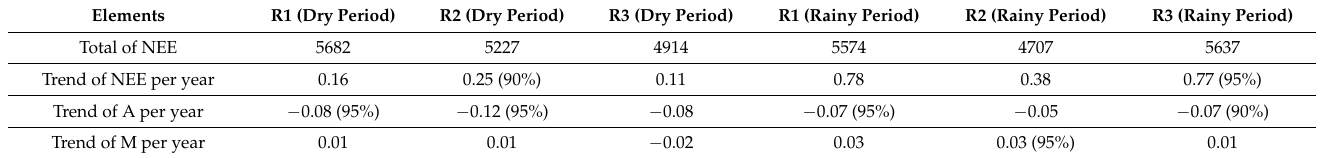
Figure 12. Regions obtained from the cluster analysis for the dry ( a ) and rainy ( b ) periods. The criteria used for the selection of the optimal number of k. Elbow plot ( c , d ). Silhouette coefficient ( e , f ). Table 2. Total number of extreme events and trend of the ranking elements for each region. The percentage shows the level of statistical significance. Dry and rainy periods